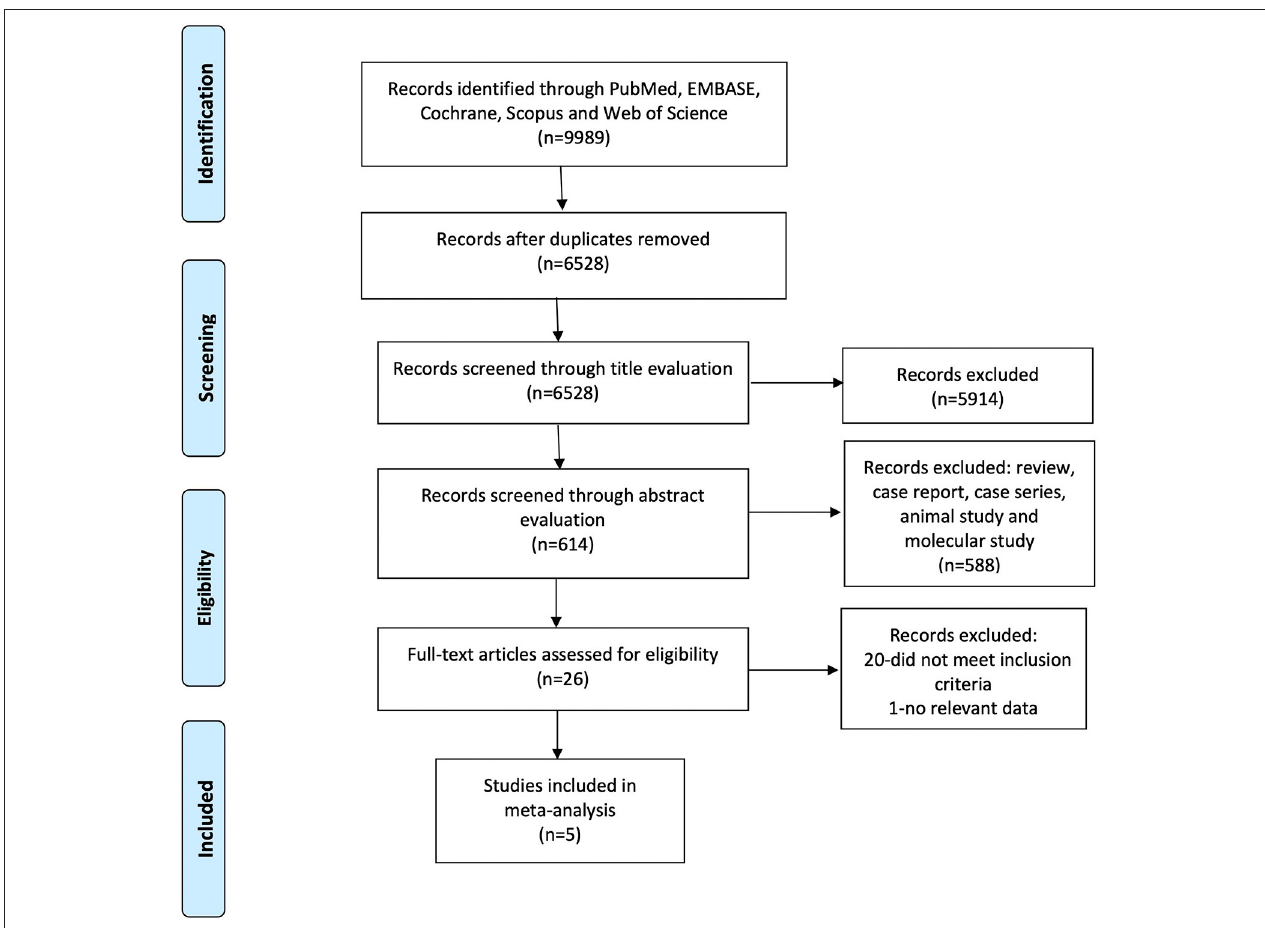
FIGURE 1 | Flowchart of screening studies in this